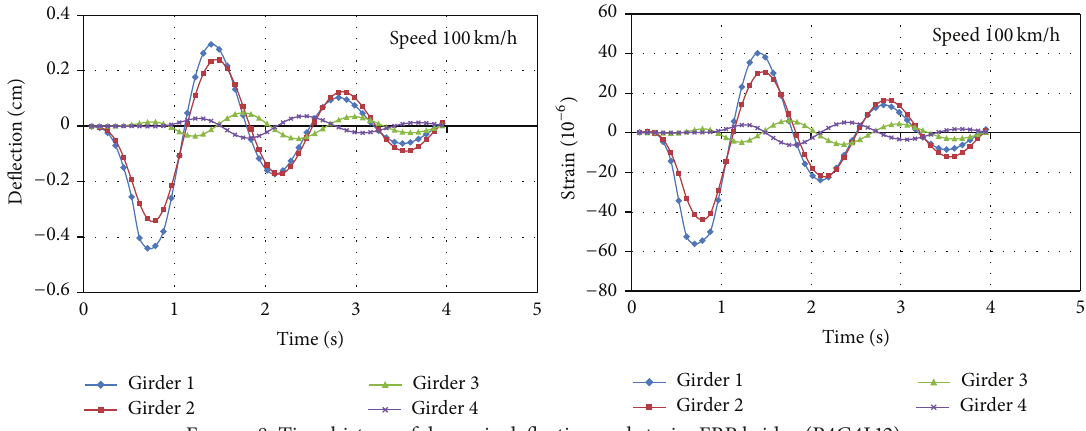
Figure 8: Time history of dynamic deflection and strain: FRP bridge